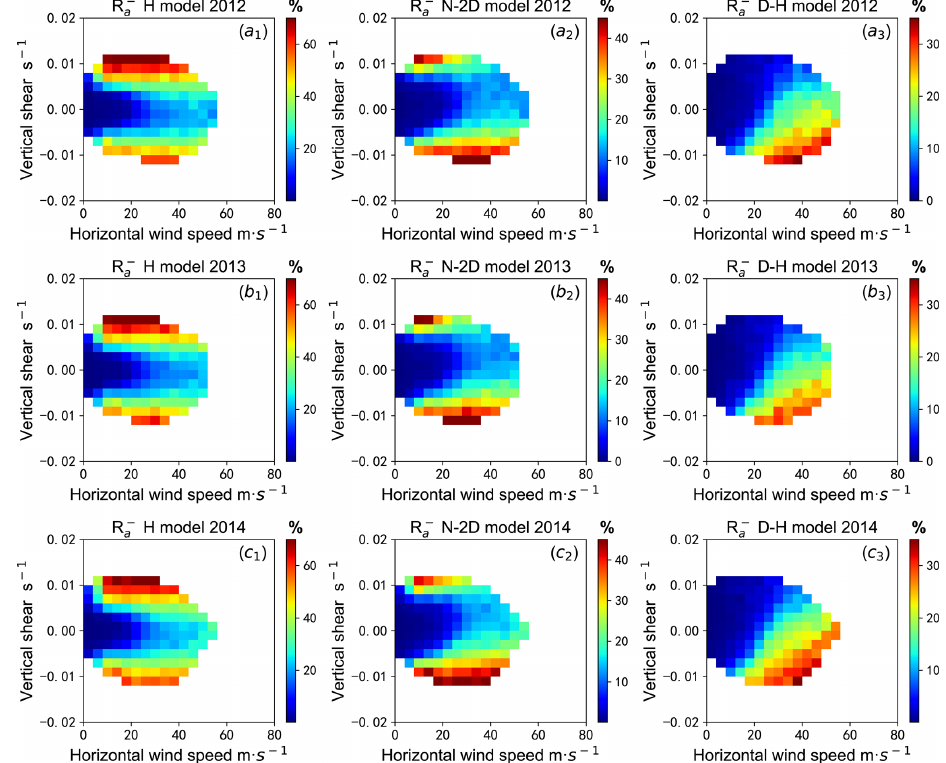
Figure 3. Distribution of R − a for the (a.1) H model, (a.2) N-2D model and (a.3) D–H model in 2012. Panels (b.1) – (b.3) and (c.1) – (c.3) are the same as (a.1) – (a.3) but for the results of the three models in 2013 and 2014,